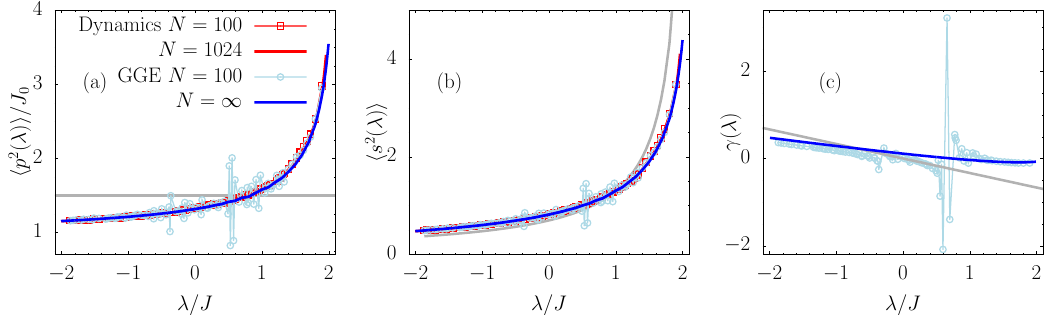
Figure 11: Comparison of the dynamic and GGE results in phase I with energy = 1.5 J injection, T and J = 0.4 J . (a) The averaged p 2 ( λ ) , (b) the averaged 0 0 0 s 2 ( λ ) and (c) the Lagrange multipliers γ ( λ ) . Finite size dynamic data for N = 100 and N = 1024 compared to the GGE analytic results. Here and in all following plots we measure p 2 in units of J , which is set to 1 as well as m . All grey curves 0 represent the pre-quench equilibrium values; in (a) they are the initial temperature, / J = 1.5, in (c) γ = − β (cid:48) λ ( 0 ) / 2 = − J λ / ( 2 T T J ) = − 0.33 λ µ / J . All quantities µ µ µ 0 0 0 0 are finite at the edge of the